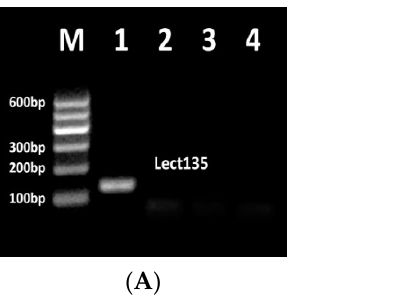
Figure 2. PCR detection of soybean allergen lectin using primer pair lect135f/lect135r ( A , lanes 1–4), GMO allergen epsps using primer pair epsps114f/epsps114r ( B , lanes 1–5) and epsps172f/epsps172r ( C , lanes 1–5). Samples: ( A ) lane 1. soybean seeds flour, lanes 2–4. water (negative control); ( B , C ) Lanes 1–4. CRMs of Roundup Ready soybean (RRS) set: 0, 0.1%, 0.5%, 10%; lane 5. water (negative control); M . Molecular weight marker (Qiagen GelPilot 100 bp ladder).